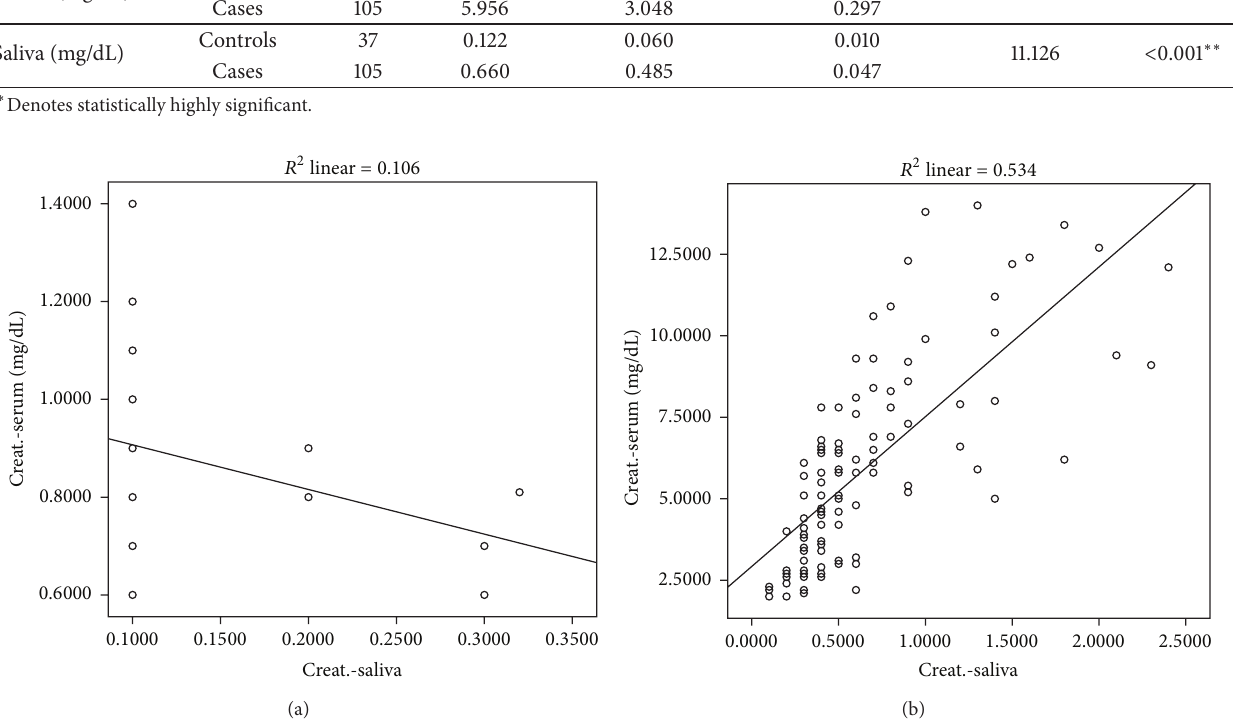
Figure 1: (a) Scatter diagram showing linear correlation between salivary serum and creatinine levels among controls. (b) Scatter diagram showing linear correlation between salivary serum and creatinine levels among CKD patients.